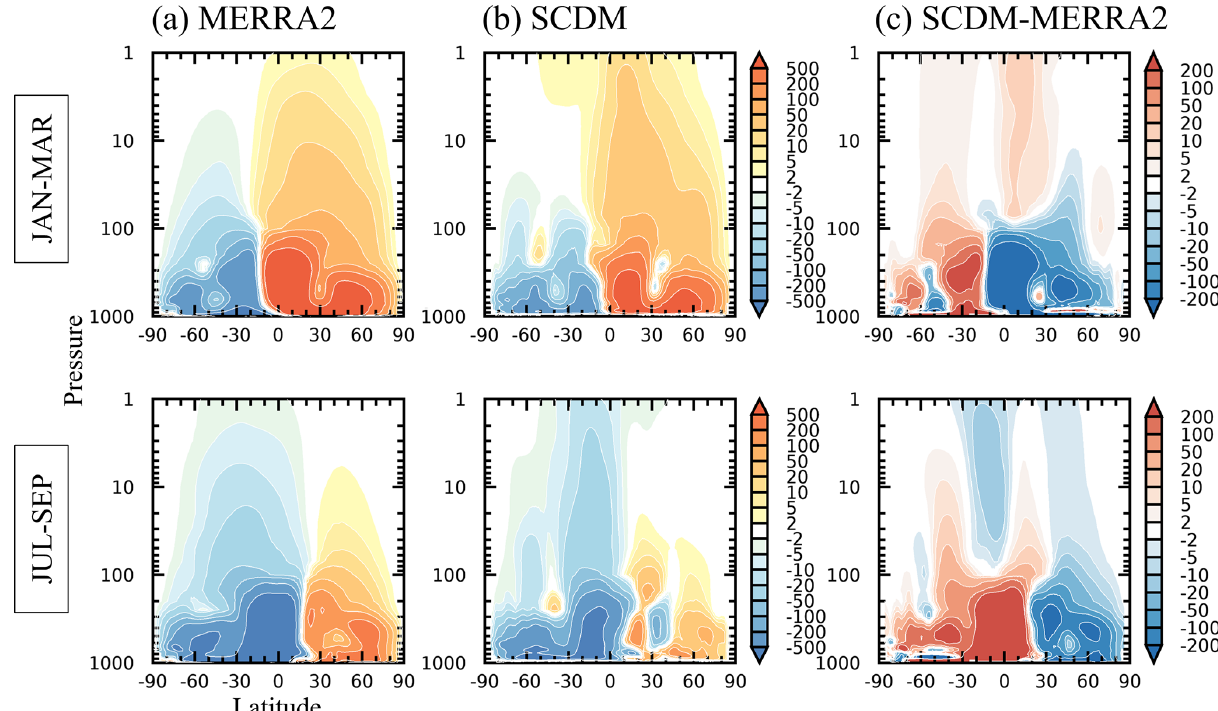
Figure 6. As Fig. 5 but for the residual mean mass streamfunction (10 6 kgs − 1 ) .